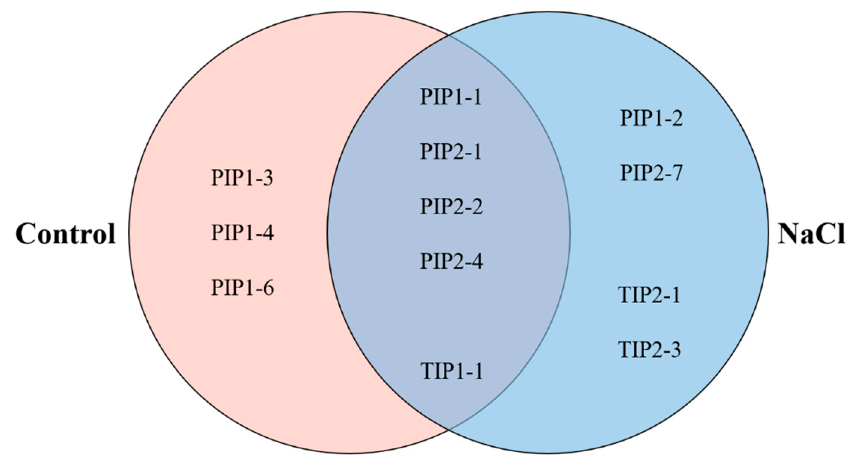
Figure 8. Venn diagram aquaporin distribution in detergent-resistant membranes (DRMs). Different sections show aquaporins found only in the control ( left ) and NaCl ( right ) and aquaporins present in both the control and NaCl (middle).